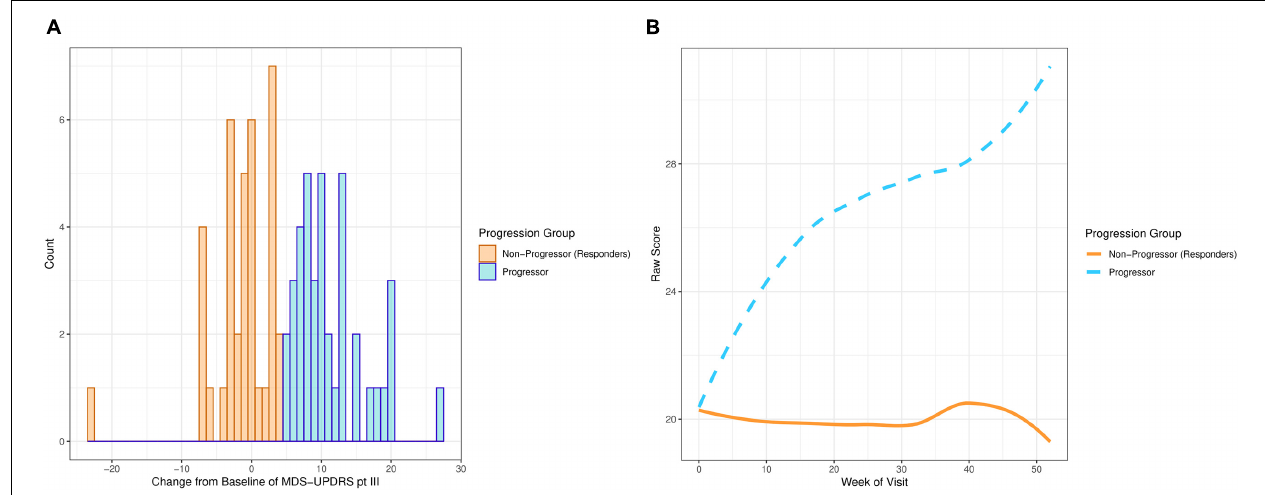
FIGURE 1 | Plots showing MDS-UPDRS part III scores of the PD participants on the placebo arm in PASADENA. (A) Distribution of change from baseline. (B) Smoothed average score by week of